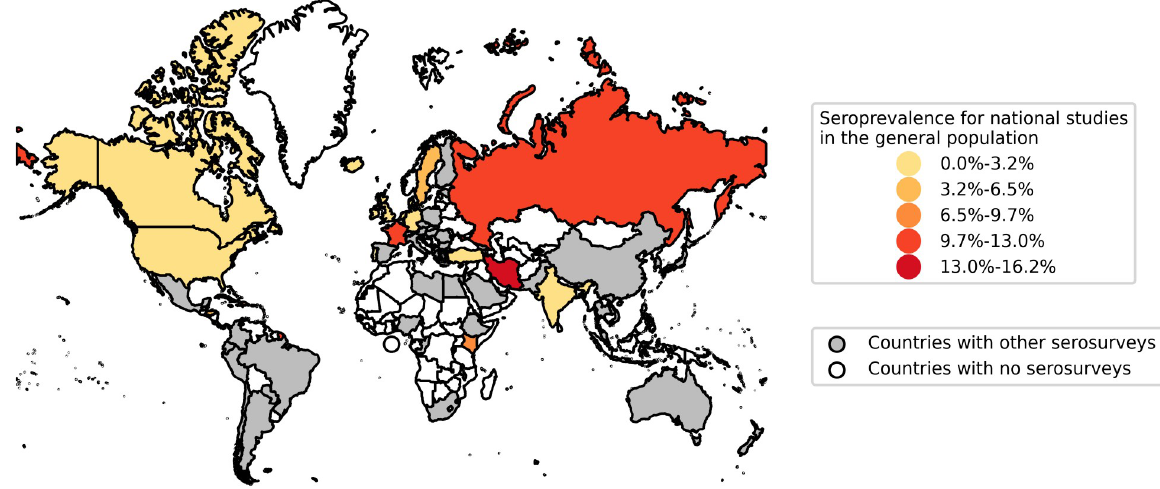
Fig 2. Map of national seroprevalence studies reporting population-wide estimates. Countries with national-level seroprevalence studies reporting population-wide estimates are coloured on the map, based on the seroprevalence reported in the most recent such study in each country. Countries with no such national serosurveys but with “other serosurveys” are coloured in grey; this includes local and regional studies, as well as studies in specific populations. Map data reprinted from Natural Earth under a CC BY license, with permission from Natural Earth, original copyright 2009.